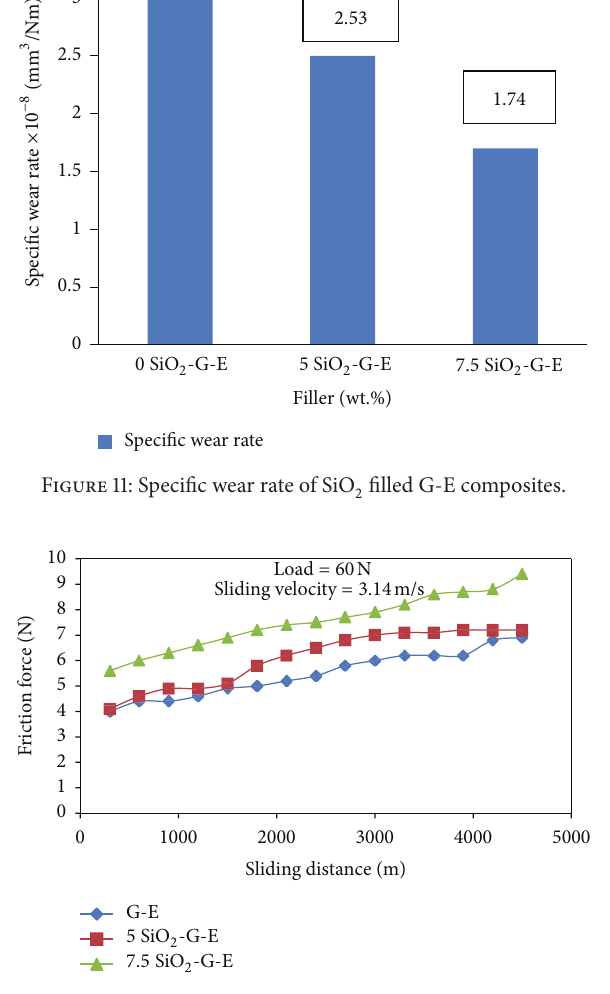
Figure 12: Frictional force of SiO 2 filled G-E composites. barrier and also prevent large scale of fragmentation of epoxy matrix.